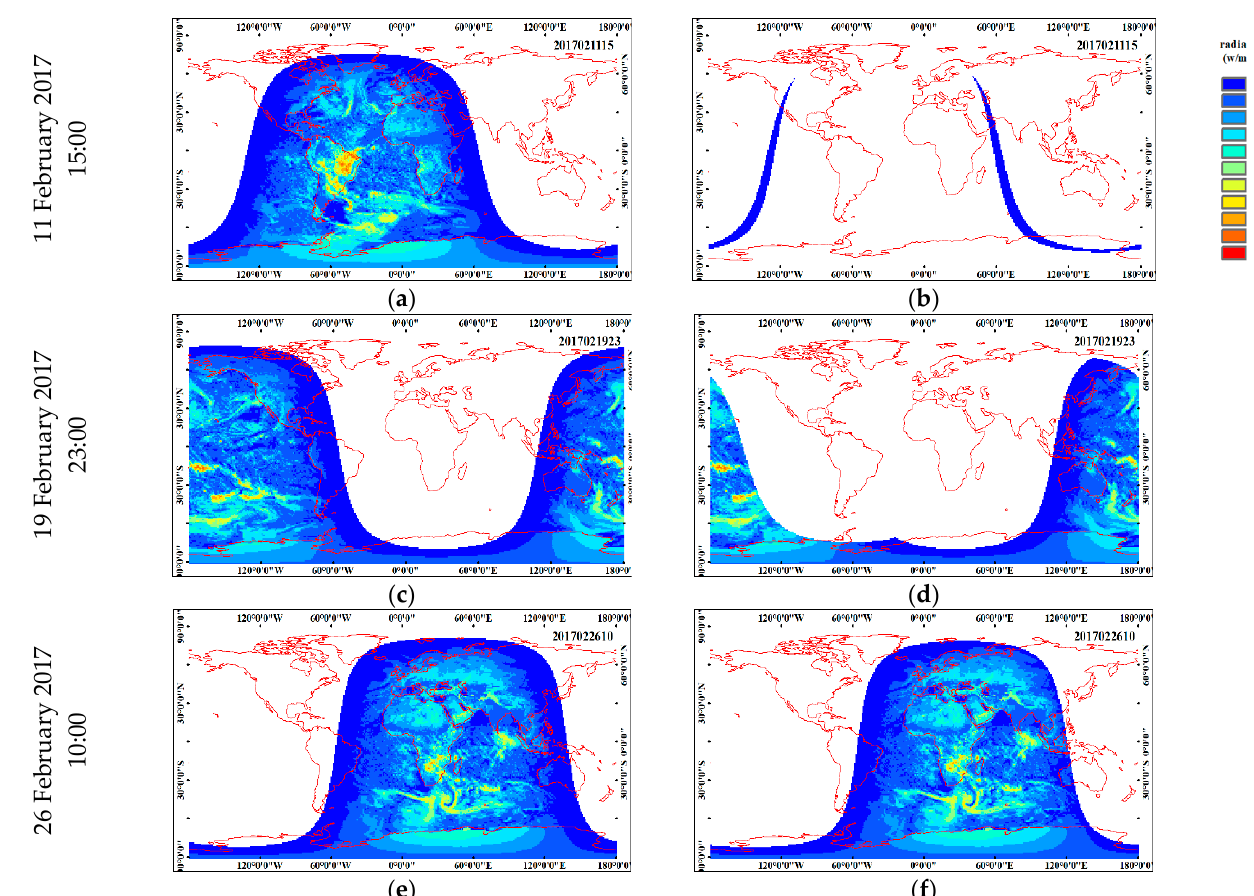
Figure 5. The hourly TOA outward shortwave radiative flux of the whole Earth derived from ERA5 (images in the first column, i.e., a , c , e ) and the hourly TOA outward shortwave radiative flux of the Earth surface in the Moon-based view (images in the second column, i.e., b , d , f ). The images in each row were obtained at the same UTC time.